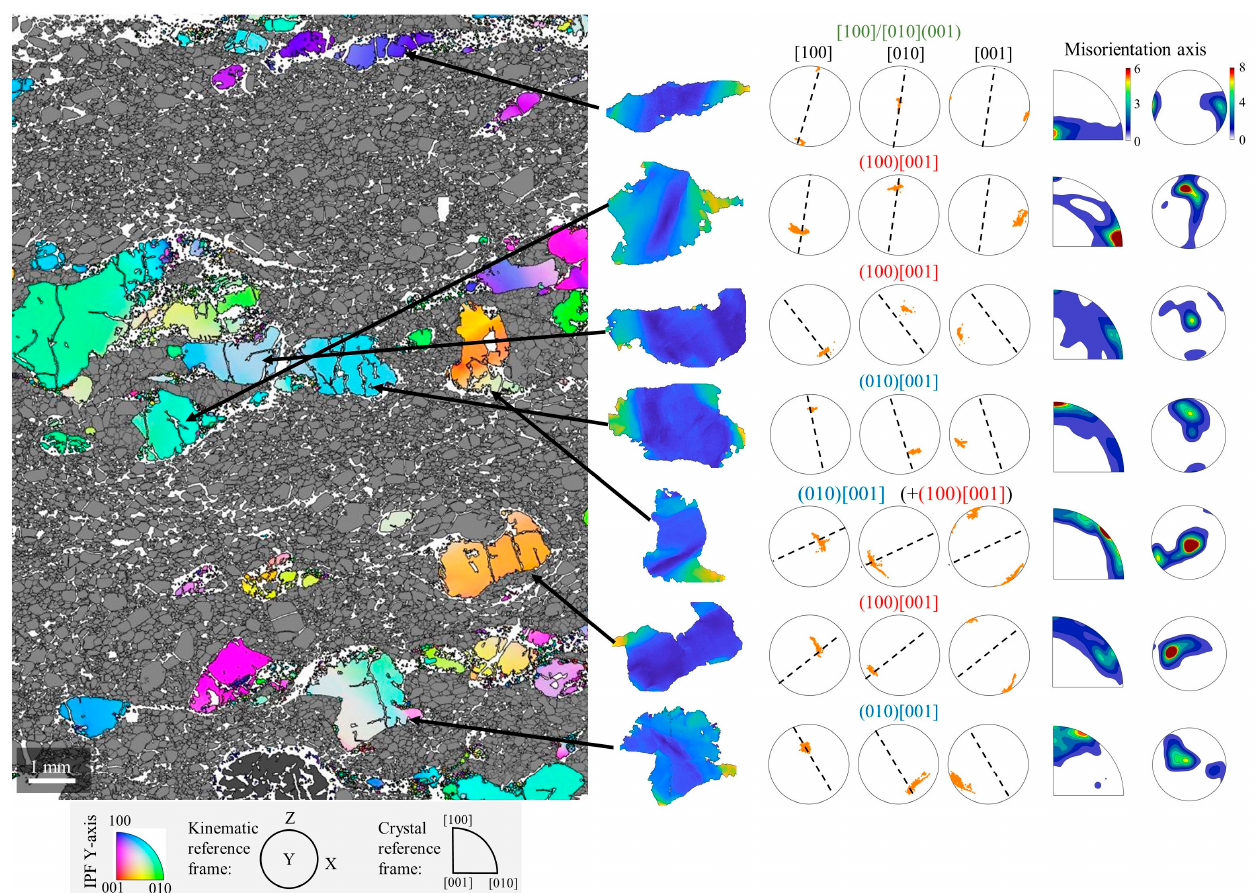
Figure 8. Analysis of subgrain boundaries in orthopyroxene (opx) grains. The map (left) highlights opx grain orientations (olivine in grey and garnet in dark grey). The crystallographic orientation spread within the highlighted grains is shown through the pole figures of the [100], [010], and [001] axes. Preferred orientation of the misorientation axis in the crystal references frame (inverse pole figure) and sample reference frame (pole figure) are shown at